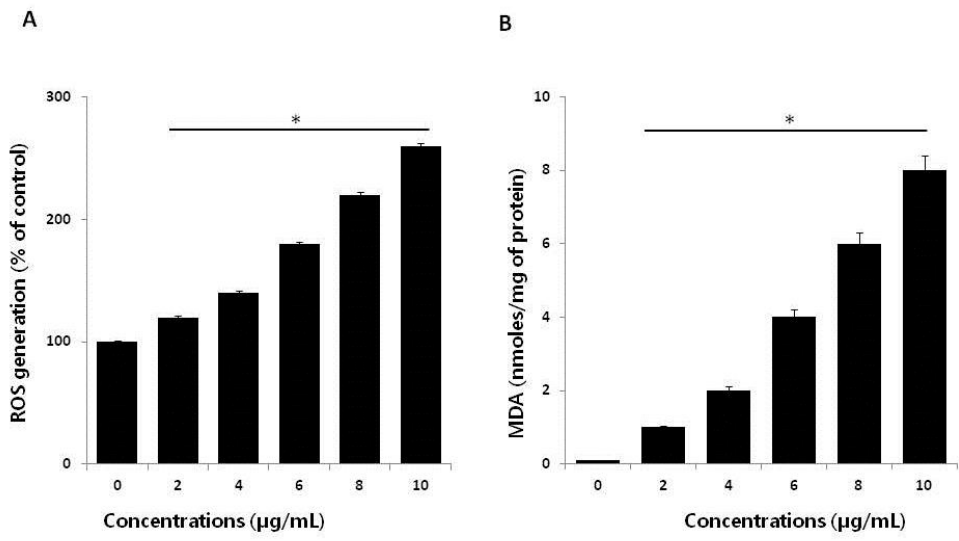
Figure 4. Effect of AgNPs on reactive oxygen species (ROS) generation. ( A ) HCT116 cells were treated with or without AgNPs for 24 h, and ROS generation was measured using 2′,7′- dichlorodihydrofluorescein diacetate (DCFH-DA). ( B ) HCT116 cells were treated with AgNPs for